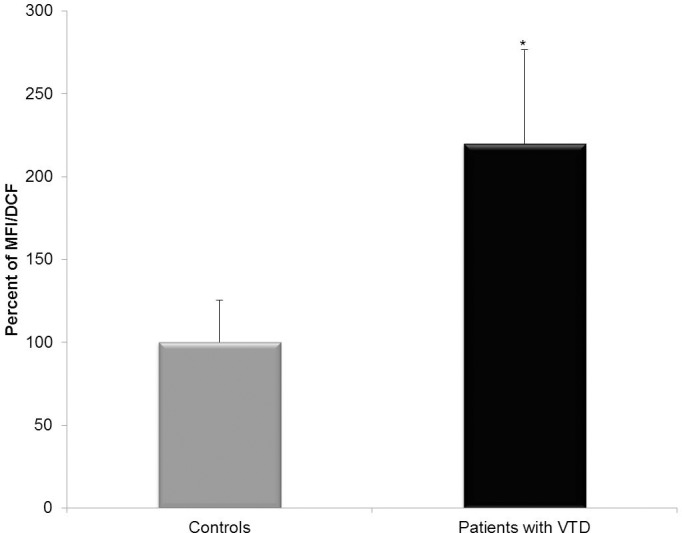
Expression of ROS in ECFC-ECs obtained from blood of controls and patients with VTD.Mean fluorescence intensity (MFI) emitted by 2’,7’-dichlorofluorescein (DCF) in ECFC-ECs from peripheral blood samples of controls and patients with VTD in passage 4. MFI was expressed as percentage being 100% the value obtained by ECFC-ECs from controls. The results are expressed as mean ± standard deviation of three independent experiments *P = 0.012.